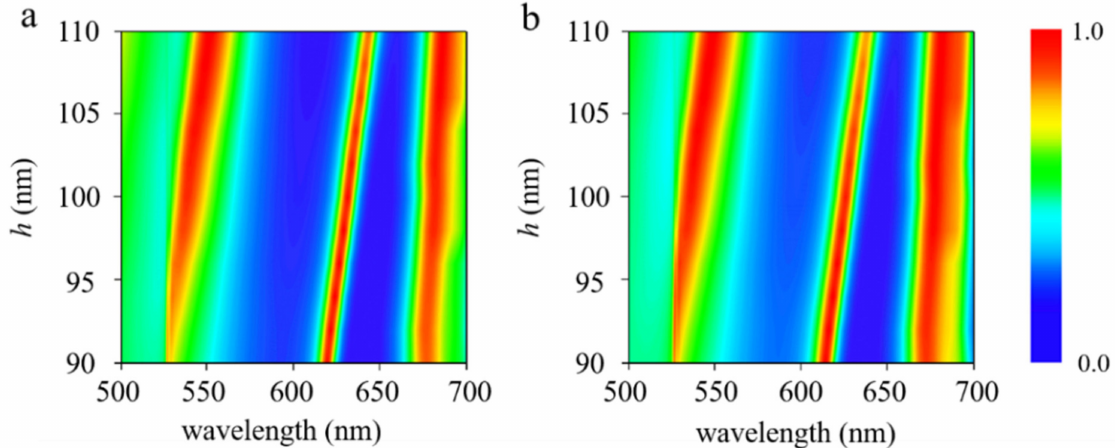
Figure 4. Absorption spectra of the proposed structure as a function of wavelength and the height of SiO 2 dielectric layer h , with polarization along ( a ) [100] and ( b ) [001] crystalline directions of α -MoO 3